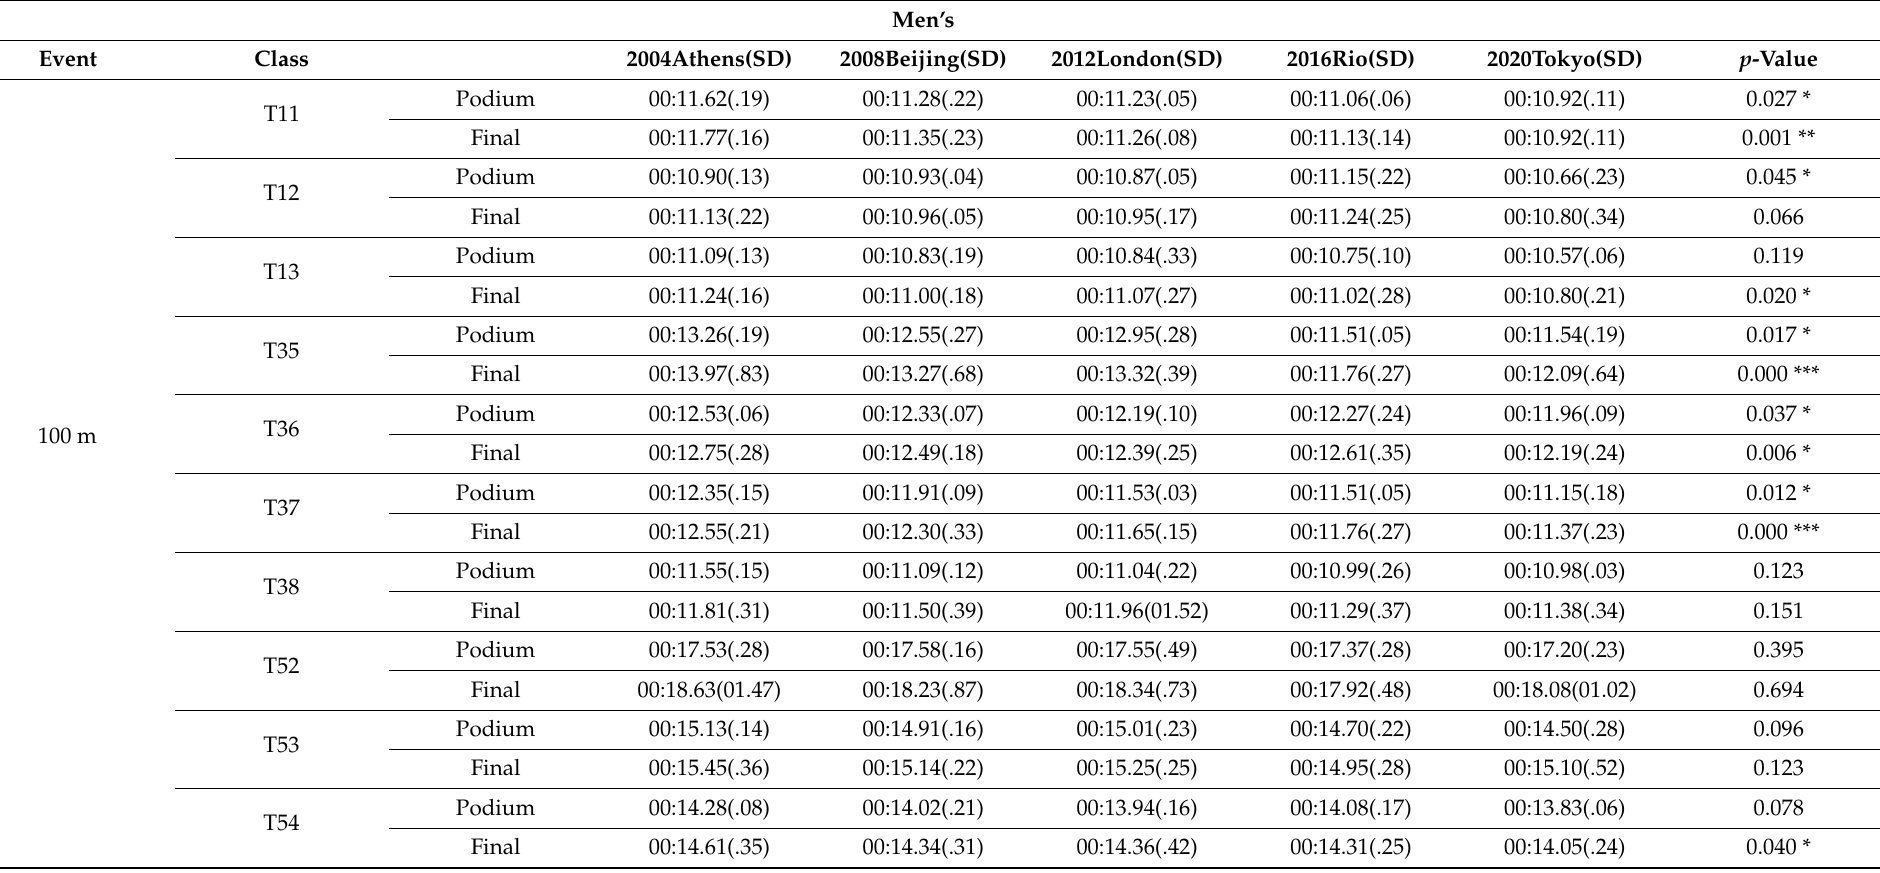
Table 3. Men’s Division Differences by Class in the Track Events of the Paralympic Games (s).